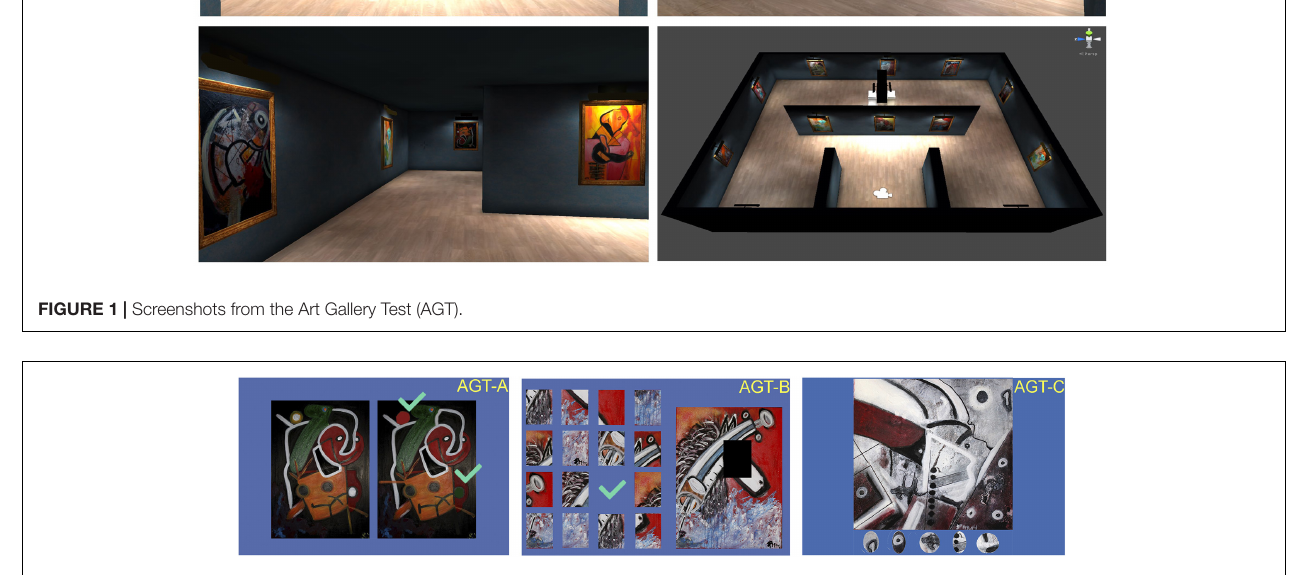
FIGURE 2 | Examples of the AGT’s tasks: subtest A (AGT-A); B (AGT-B) and C